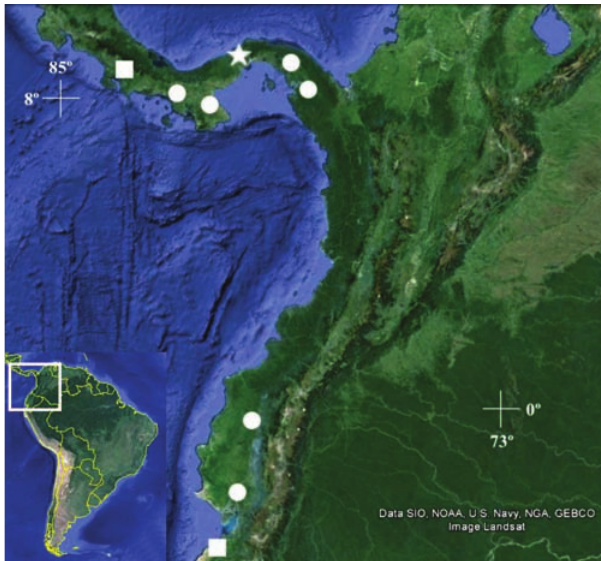
Fig. 4. Map of Northwestern South America and part of Central America showing geographic distribution of Hoplias microlepis based on material examined herein (star and dots) and records from literature (squares). Star indicates type-locality at Chagres River, Panama. Some symbols may represent more than one